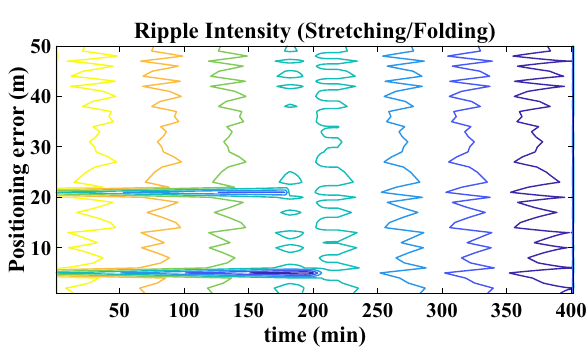
Ripple Intensity (Stretching/Folding)